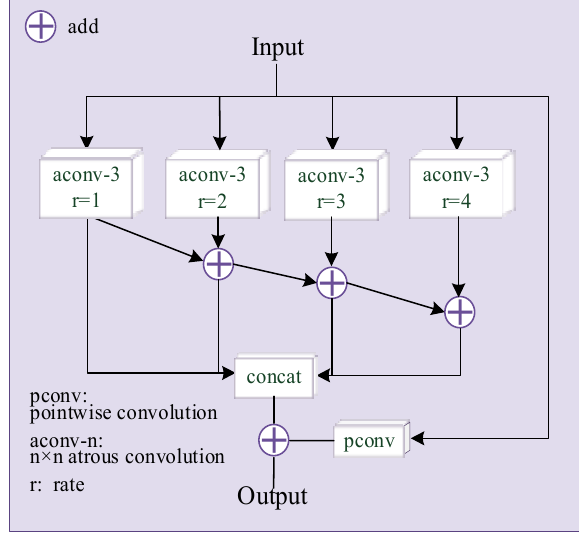
Figure 3. The structure of MFM.